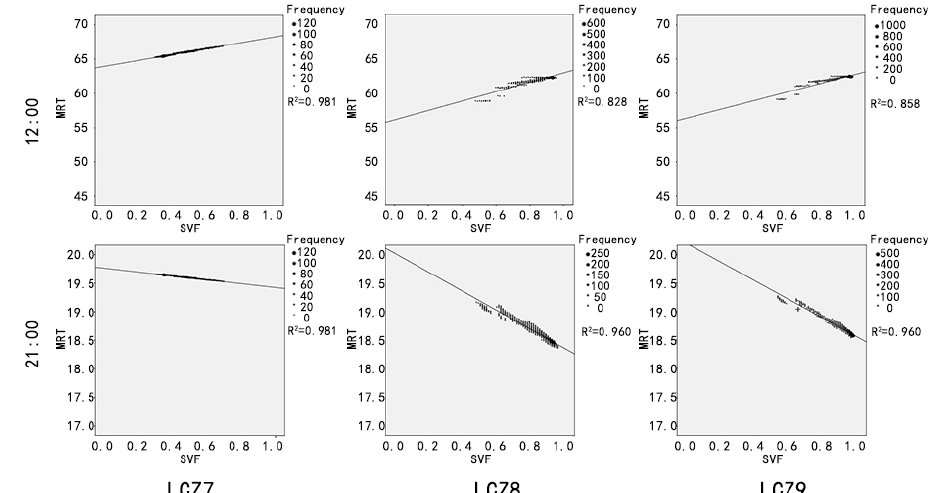
Figure 8. Correlation between SVF and MRT for the nine models at 12:00 and 21:00, with indication of the square of the correlation coefficient R 2 . Please note that, when two values of R 2 are present, R 2 refers to the direct-radiation area and R 2 * to the shadow area.